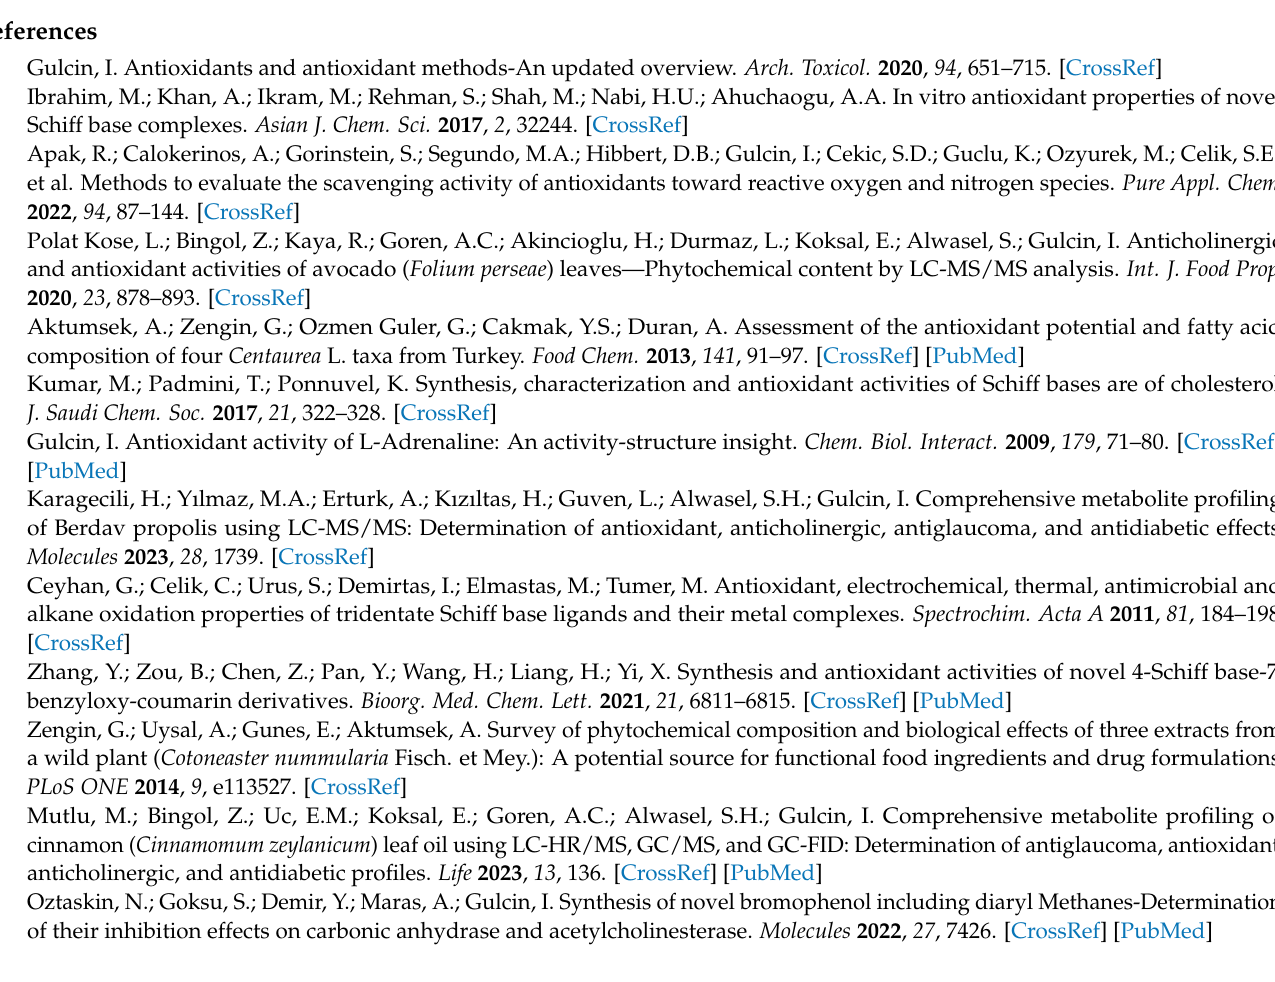
synthesized compounds. Figure S1: The reducing ability of 10–30 µ g/mL of Schiff bases ( 10 – 15 ), hydrazineylidene derivatives ( 16 – 17 ) and standards. (A) Fe 3+ reducing effect, (B) Cu 2+ reducing effect, (C) Fe 3+ -TPTZ reducing effect. Figure S2: Radical removing abilities of different concentra- tions (10–30 µ g/mL) of Schiff bases ( 10 – 15 ), hydrazineylidene derivatives ( 16 – 17 ), and